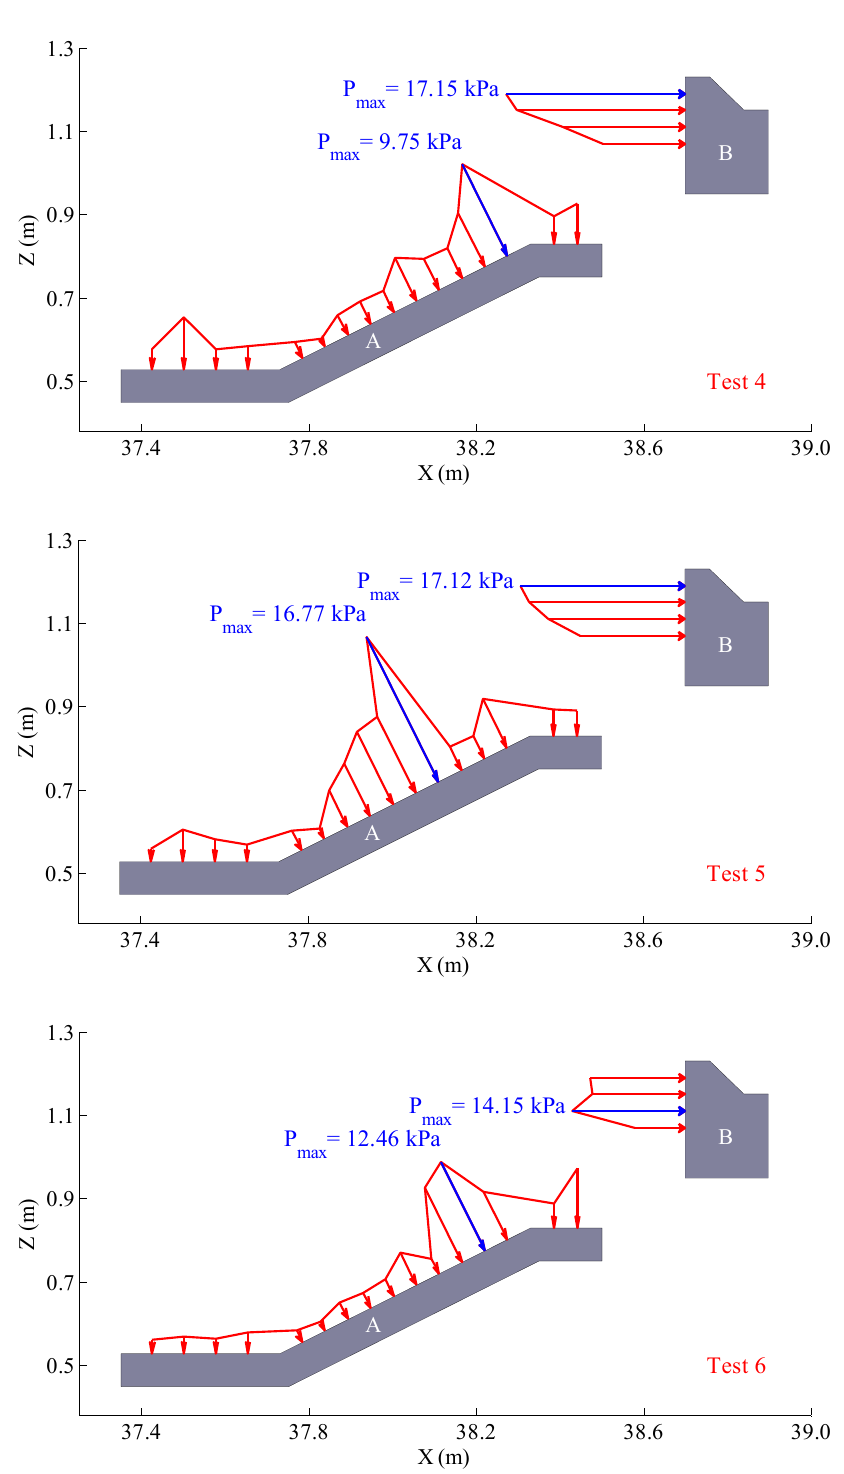
Figure 20. Distribution of the maximum wave impact on the surface of the revetment breakwater under regular wave loading in Test 4 (accropodes), Test 5 (rubble) and Test 6 (accropodes and rubble).